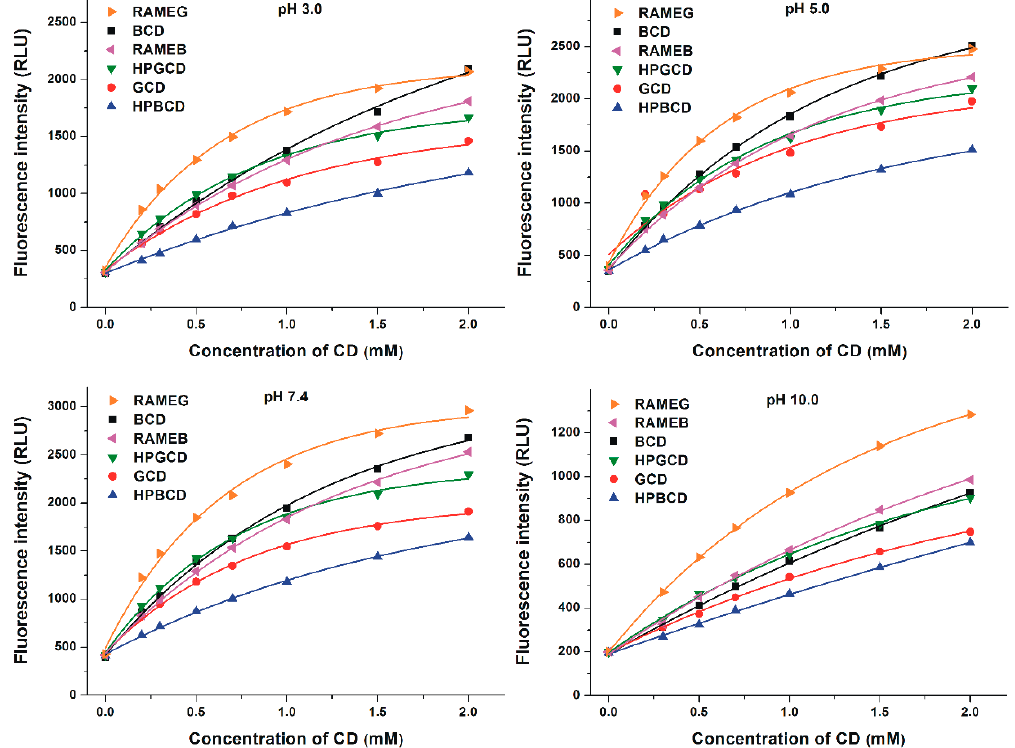
Figure 5. CD-induced increase in the fluorescence signal of Z14G (1 µM) in different buffers (0.05 M sodium phosphate, pH 3.0; 0.05 M sodium acetate, pH 5.0; 0.05 M sodium phosphate, pH 7.4; 0.05 M sodium borate, pH 10.0; λ ex = 315 nm, λ em = 455 nm). Table 1. CD-induced relative increase in the fluorescence emission signal of Z14G ( I / I 0 ; 1 µM